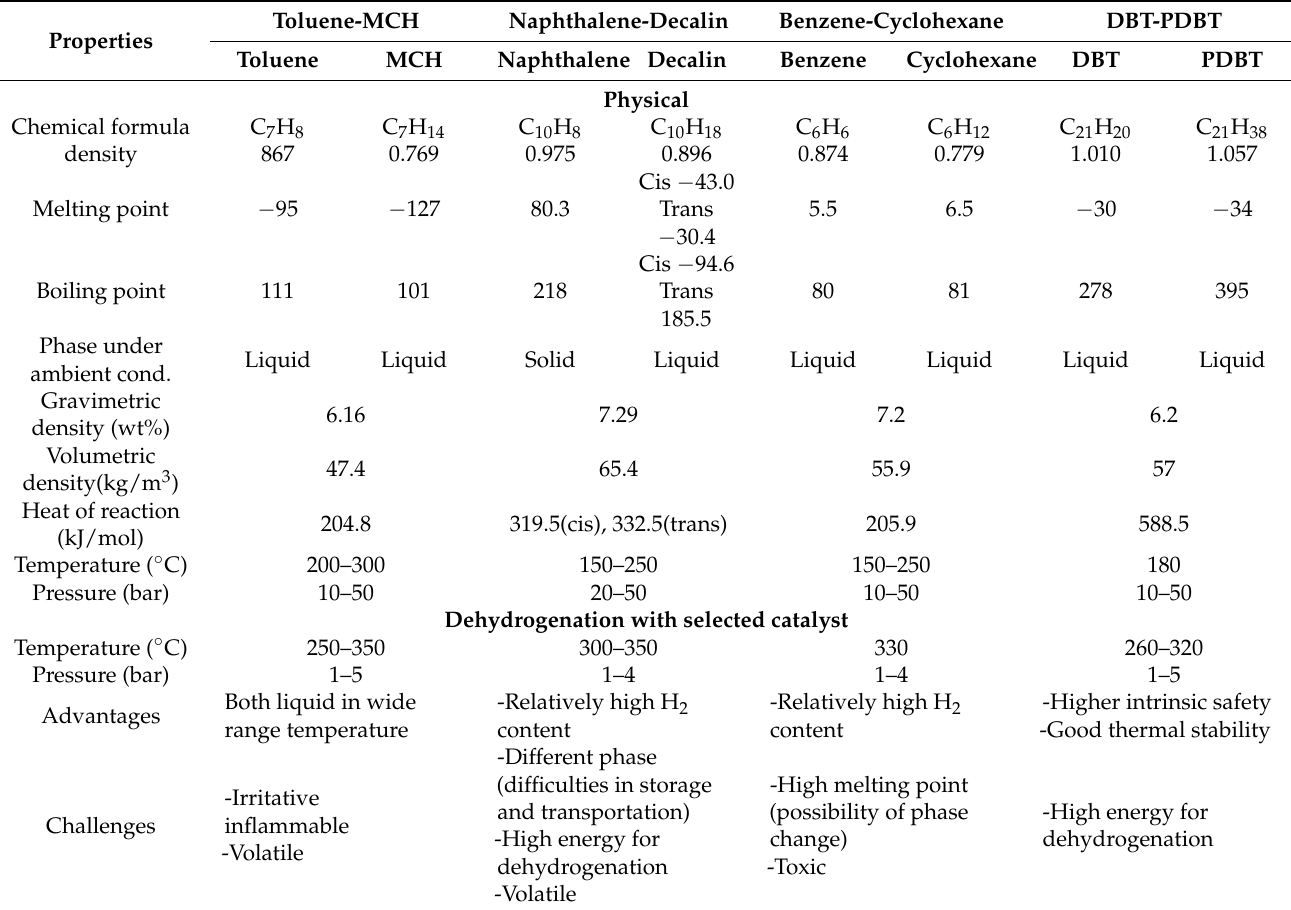
Table 6. Technical properties of some potential LOHCs